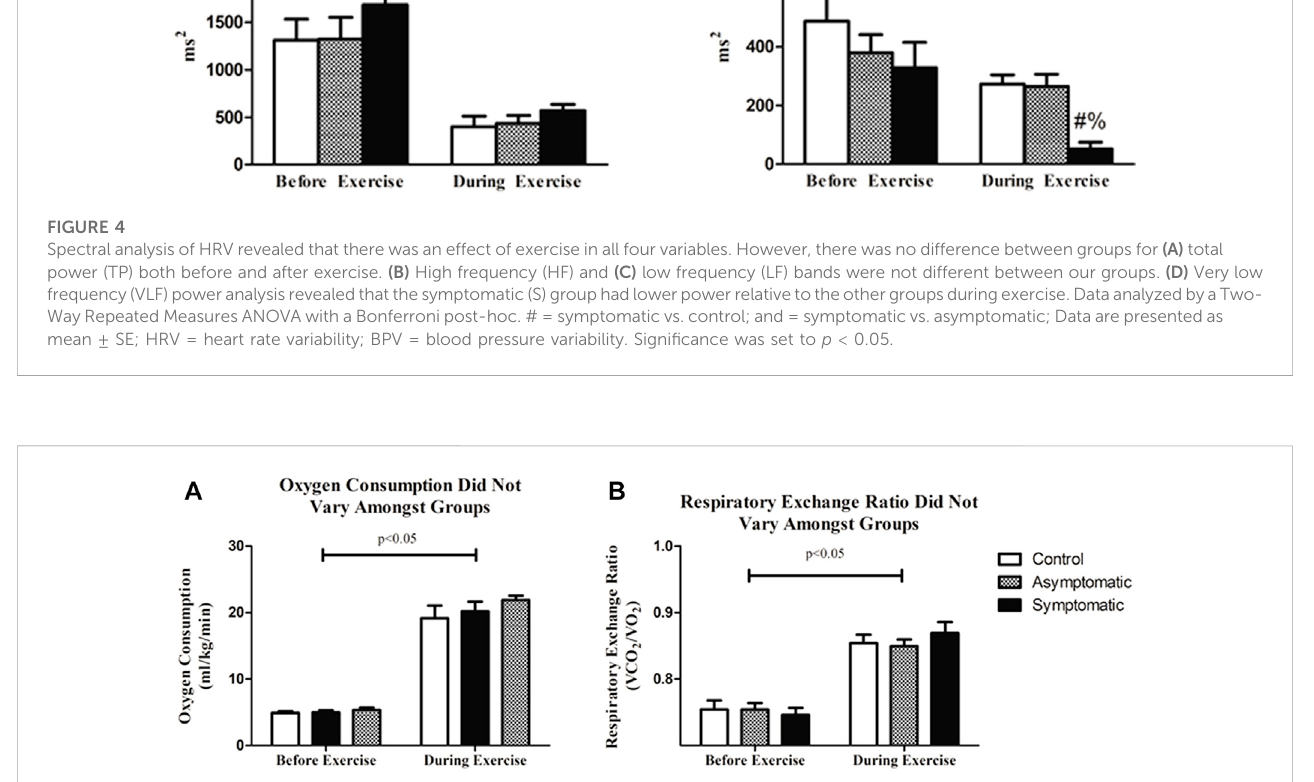
FIGURE 5 (A) Therewasnodifferenceinoxygenconsumption(VO (B) Respiratoryexchangeratio(RER)wasconsistentamongstgroups. 2 )betweenallthreegroups. Data analyzed by a Two-Way Repeated Measures ANOVA with a Bonferroni post-hoc. Data are presented as mean ± SE; VO 2 = oxygen consumption; RER = respiratory exchange